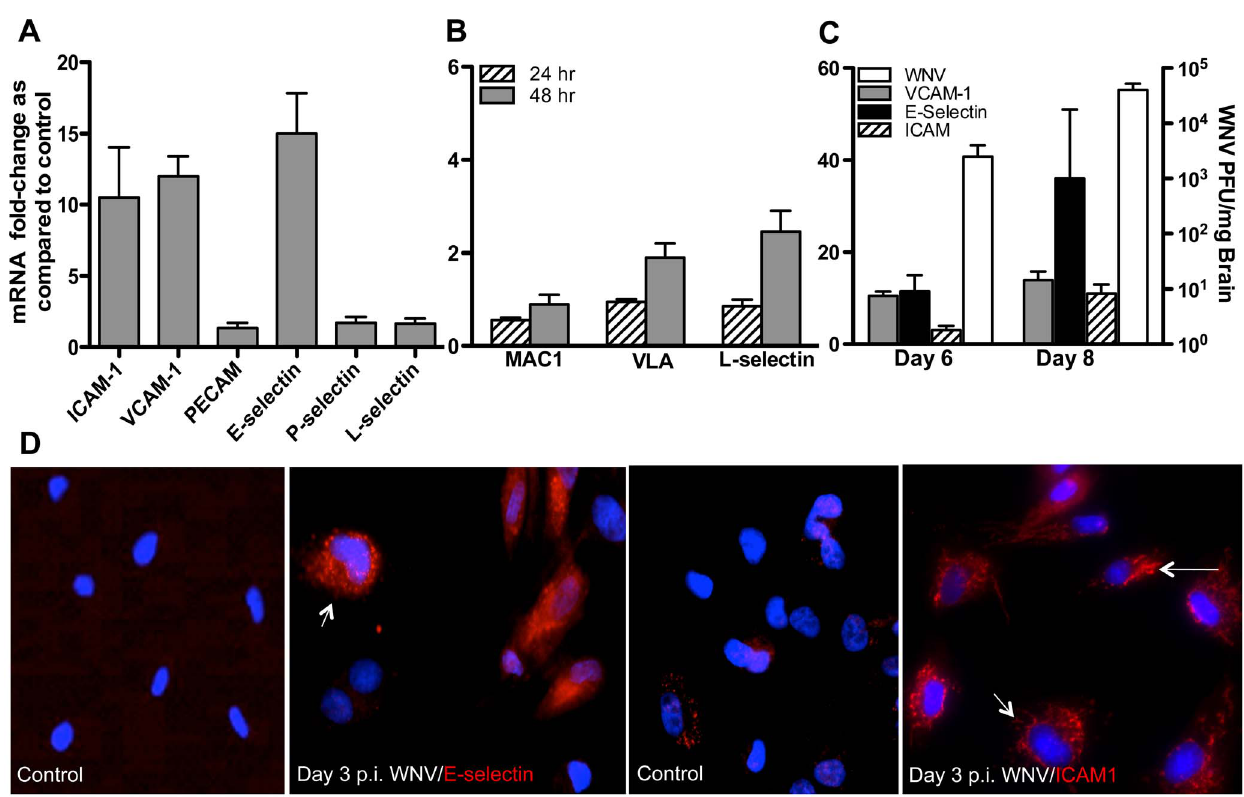
Figure 2. WNV induces expression of specific CAMs in the HBMVE cells and mouse brain. ( A ) The changes in the mRNA of multiple CAMs was measured in HBMVE cells at 72 hours after infection. ( B ) qRT-PCR was conducted on the RNA extracted from WNV-infected human monocytes to determine fold-change in the VLA-4, MAC-1 and L-selectin gene expression. ( C ) WNV titers and fold-change of ICAM-1, VCAM-1 and E-selectin in WNV-infected mouse brain as determined by qRT-PCR. The data are normalized to the values of GAPDH and are expressed as relative fold increase compared to uninfected controls. ( D ) Validation of the increase in the protein expression of ICAM-1 and E-selectin in HBMVE cells at 72 hrs after infection by immunostaining. The data are expressed as means 6 SD from two independent experiments in duplicate. *p , 0.05 compared to mock.